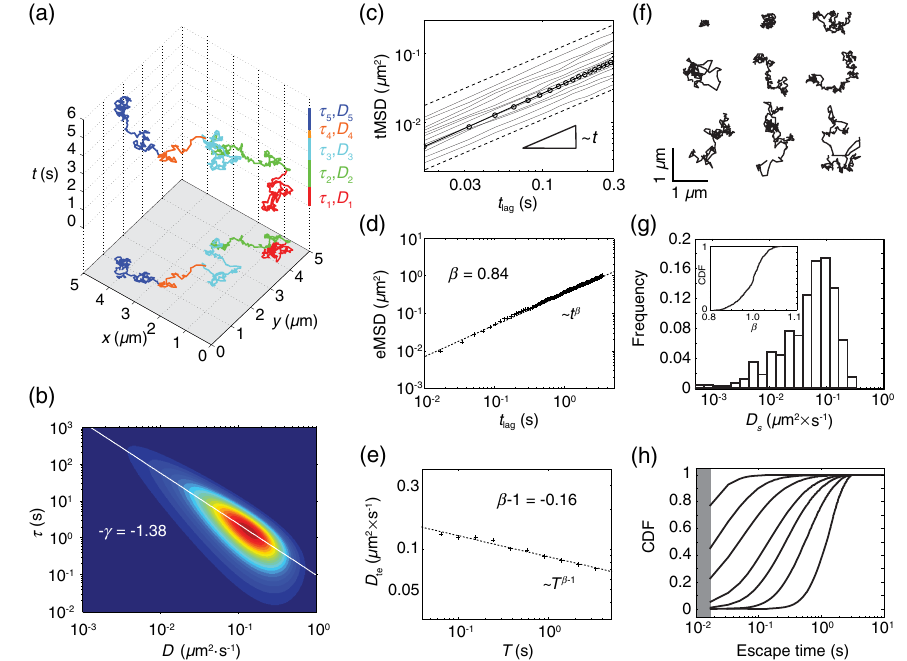
FIG. 4. Annealed model of heterogeneous diffusion quantitatively reproduces DC-SIGN motion. (a) A simulated trajectory composed by five time intervals with different transit times τ i and diffusivity D i . (b) Contour plot of the probability distribution of the simulated diffusion coefficient D and transit time τ for the parameters reproducing the dynamics of WT DC-SIGN ( σ ¼ 1 . 16 , γ ¼ 1 . 38 , b ¼ 0 . 12 μ m 2 = s, k ¼ 0 . 10 μ m 2 γ s γ þ 1 ). The white line represents the power-law dependence between diffusivity and average transit time with exponent − γ . (c) Log-log plot of the time-averaged MSD for simulated trajectories (black lines). The symbols (circle) correspond to the average tMSD. The linear fit to the log-log transformed data provides β ¼ 0 . 98 (cid:3) 0 . 03 . (d) Log-log plot of the ensemble-averaged MSD for the simulated trajectories. The dashed line represents a power law with the theoretical exponent β ¼ σ = γ ¼ 0 . 84 . (e) Log-log plot of the time-ensemble-averaged diffusion coefficient as a function of the observation time T . The dashed line represents a power law with the theoretical exponent β − 1 ¼ − 0 . 16 . (f) Simulated trajectories for the same recording time (3.2s). (g) Distribution of short-time diffusion coefficients as obtained from linear fitting of the time-averaged MSD for all the simulated trajectories. Inset: CDF of the exponent β obtained from nonlinear fitting of the tMSD of all the trajectories. (h) CDF of trajectory escape time for different radii. 20 , 50, 100, 200, 300, 500, and 1000 Curves from left to right correspond to radii R TH ¼